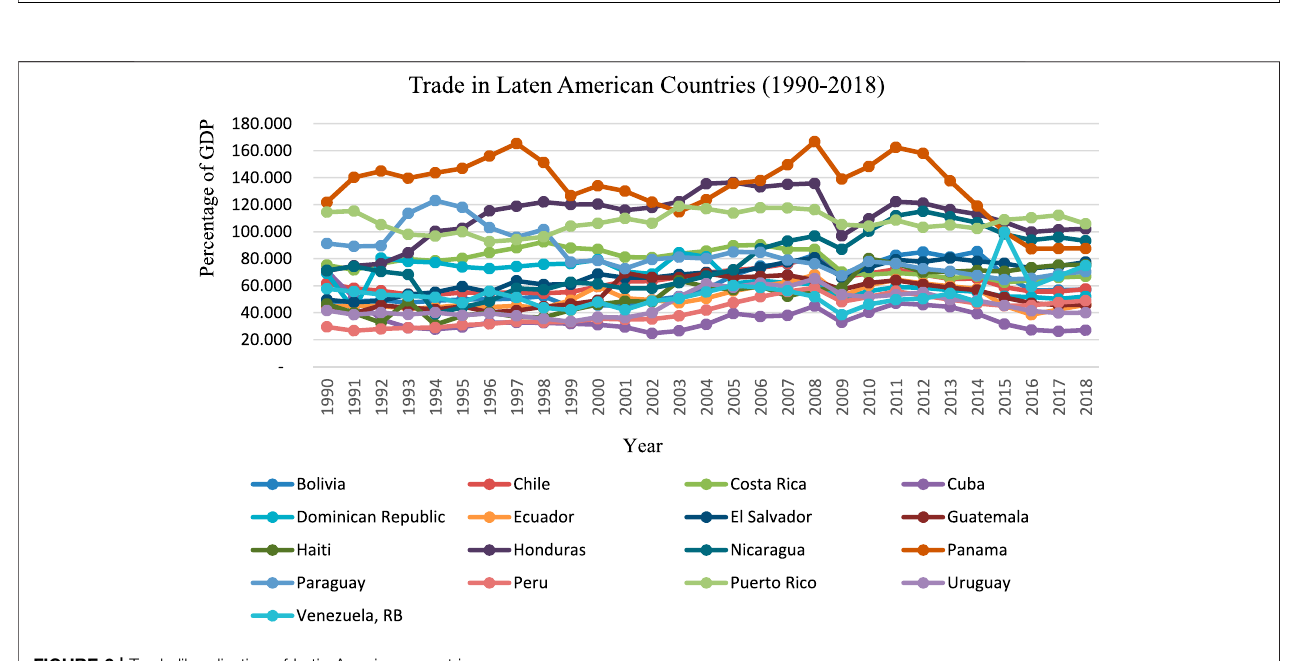
FIGURE 2 | Trade liberalization of Latin American